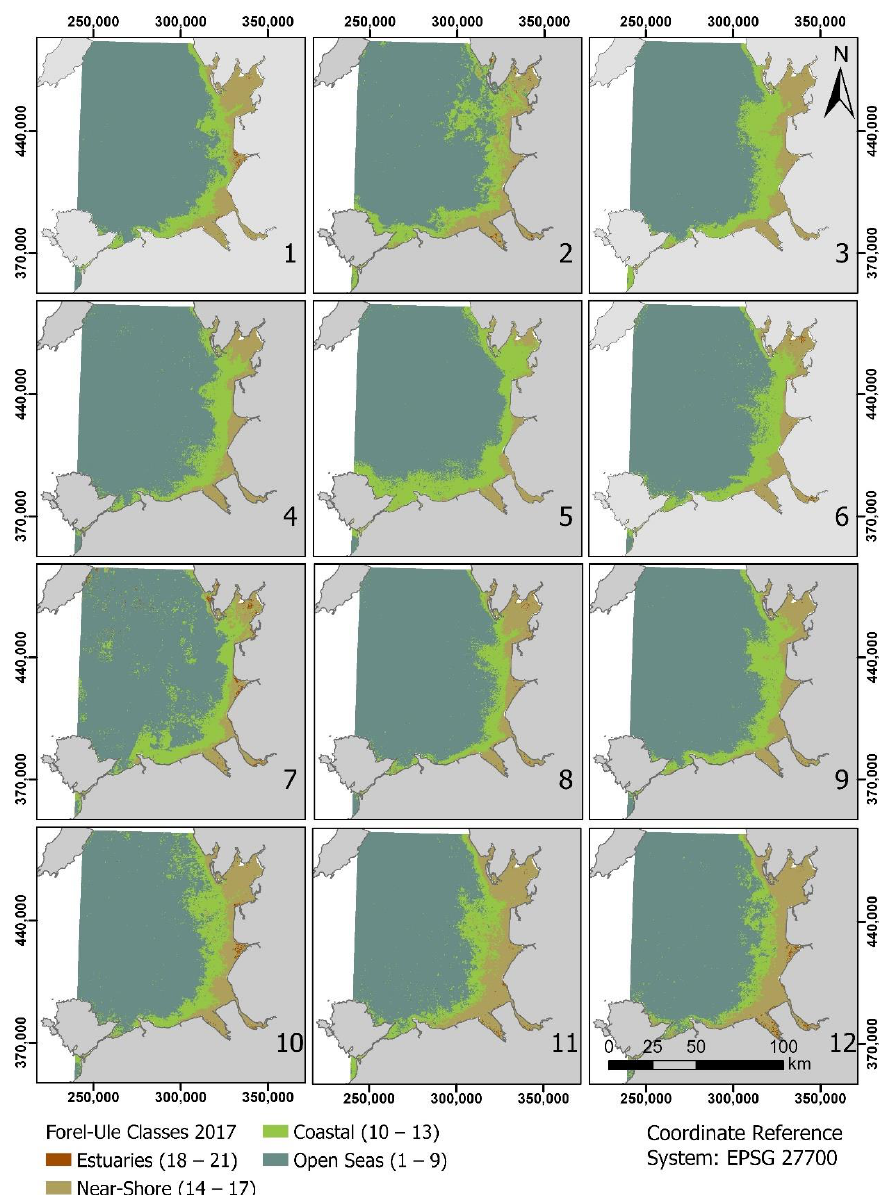
Figure 5. Spatial changes observed in the river plume extent (FUI between 10 – 21) in 2019 suggest the presence of three seasons: 1. wet season (months: 12, 1, 2, 3); 2. dry season (months: 5, 6, 7, 8) and 3. mixed season (months: 4, 9, 10, 11).